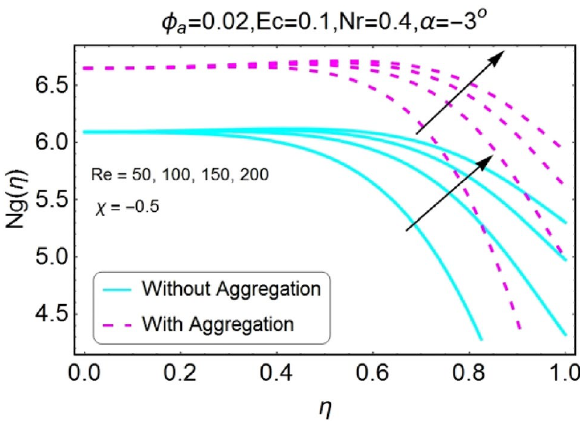
Figure 49. Re varying Ng for shrinking walls (convergent channel).